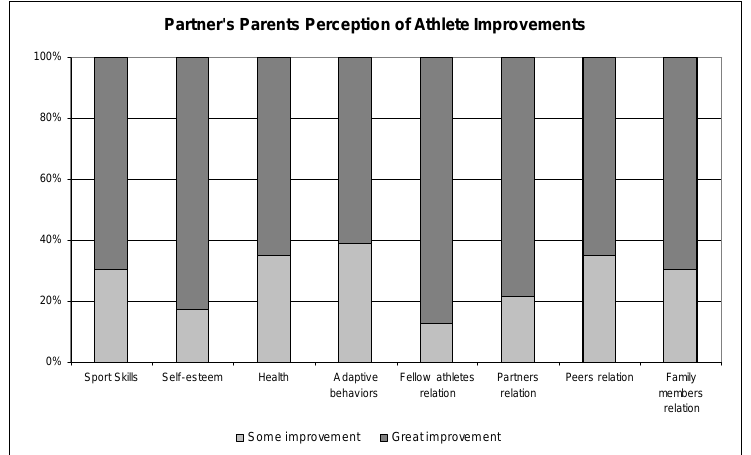
Figure 2. Perception of partners’ parents perception on athlete improvement at the end of the